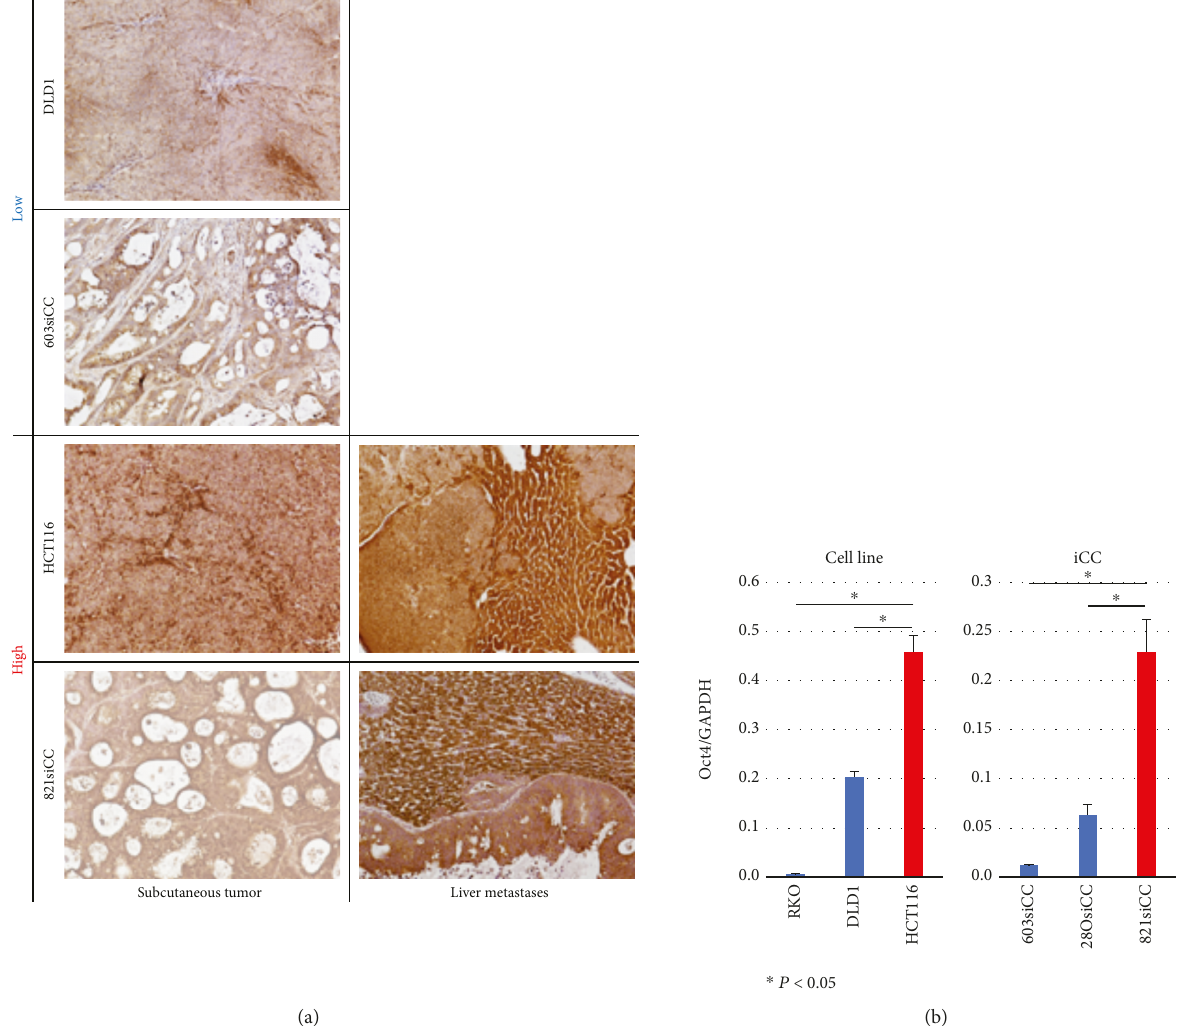
Figure 4: Oct4 protein and mRNA expression of cell lines and iCCs. (a) Representative staining of Oct4 in xenograft models: subcutaneous tumor and liver metastasis. Oct4 protein expression of subcutaneous tumor was high in HCT116 and 0821siCC, which had high liver metastasis-forming ability, compared with DLD1 and 603siCC. Oct4 protein expressions of liver metastasis formed by HCT116 and 821siCC were also high. DLD1 and 603siCC did not form liver metastasis. (b) Oct4 mRNA expression was high in HCT116 and 821siCC compared with that in other cells ( n = 3 , P < 0 05 ). Scale bar, 100 μ